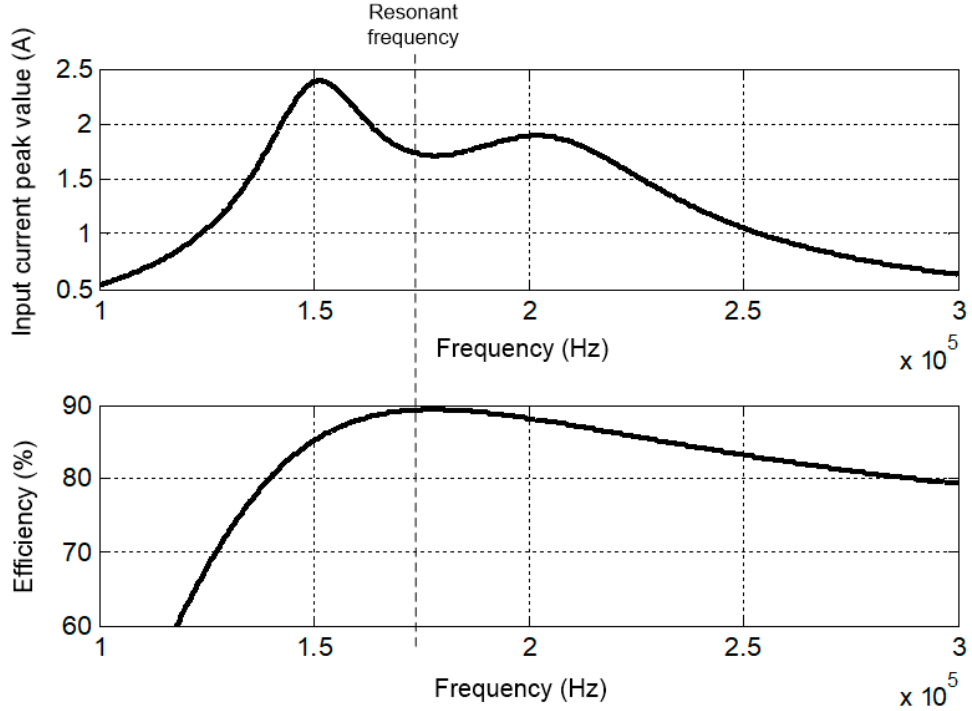
Figure 6. Theoretical input current peak value and the efficiency versus frequency of the inductive- resonant WPT system under